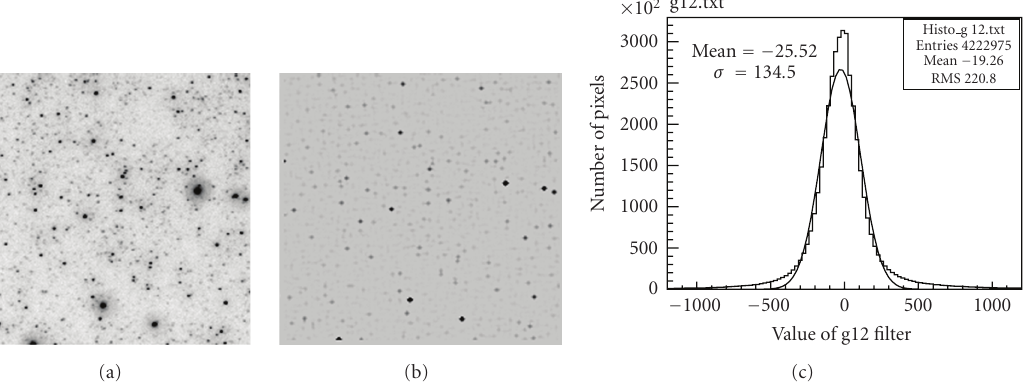
Figure 2: Sky image before (a) and after (b) applying the laplace filter, and the distribution of pixel values after laplace filter is applied